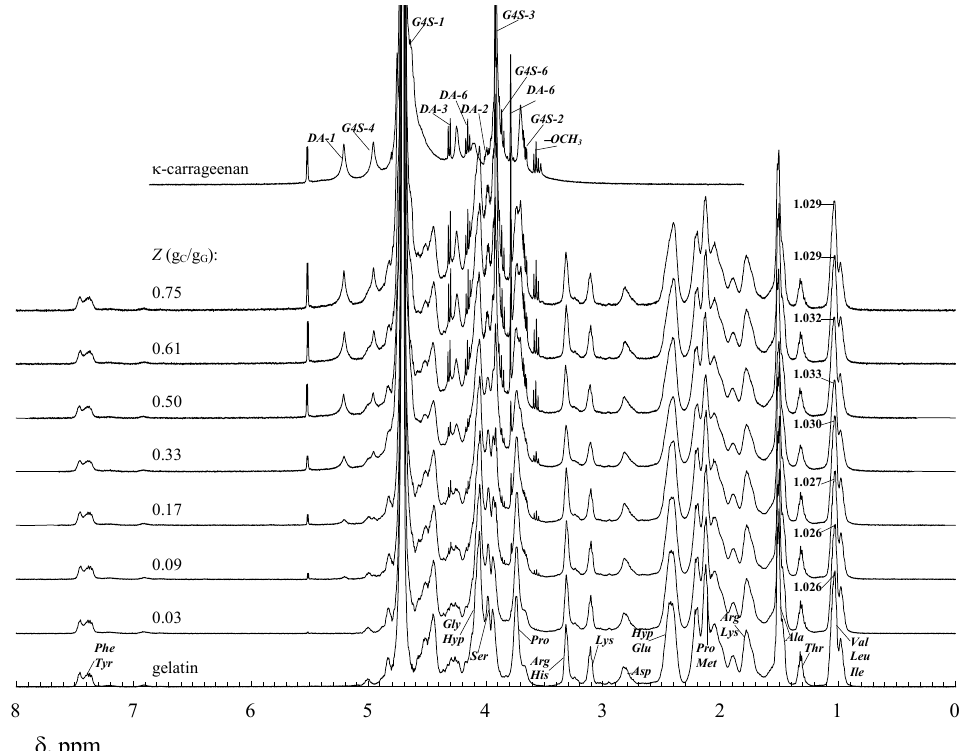
Figure 3. 1 H NMR spectra for native κ -carrageenan solution ( C C = 1.0 wt %), native gelatin solution ( C G = 2.0 wt %), and κ -carrageenan-gelatin aqueous mixtures of different κ -carrageenan/gelatin w / w ratios Z , g C /g G , in 99.8% D 2 O at 40 ◦ C. Original